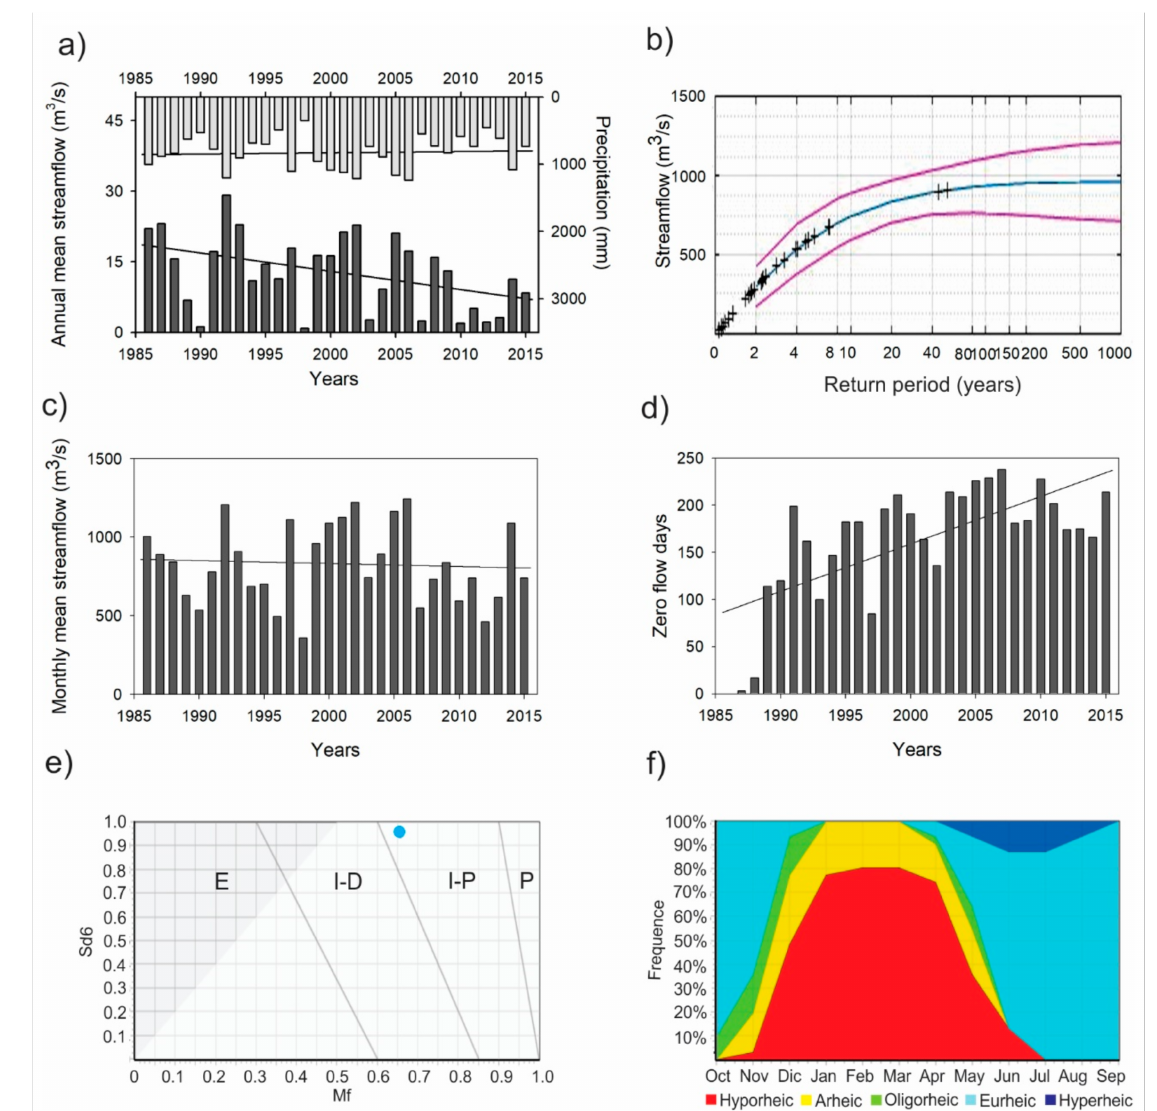
Figure 2. Annual mean streamflow and precipitation ( a ); probability of the extreme flood events (flood frequency analysis) showing 90% confidence limits (red line) and mean (blue line) ( b ); variation of the monthly mean streamflow ( c ); zero flow days ( d ); type of intermittent river (P: Perennial; I-P: Intermittent with pools; I-D: Intermittent-dry; E: Ephemeral) ( e ), and the aquatic states frequency graph ( f ) of the Lonqu é n